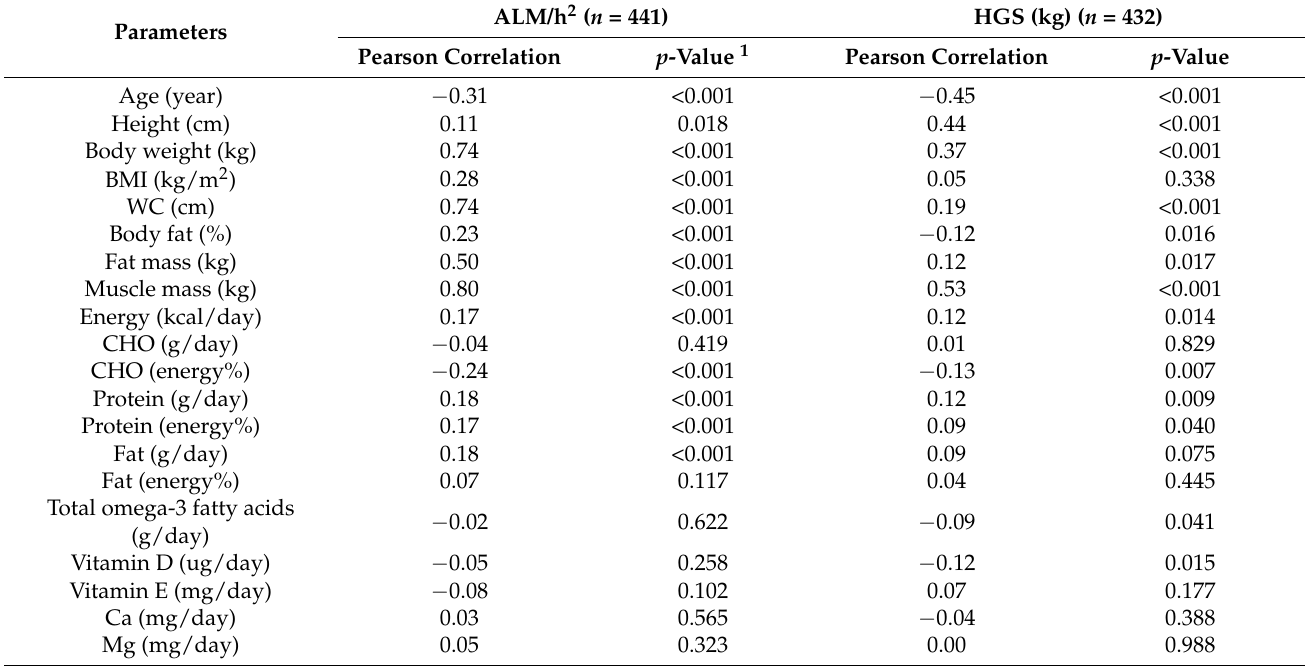
Table 4. Pearson’s correlation coefficient of ALM/h 2 and HGS with general characteristics and nutrient intake.